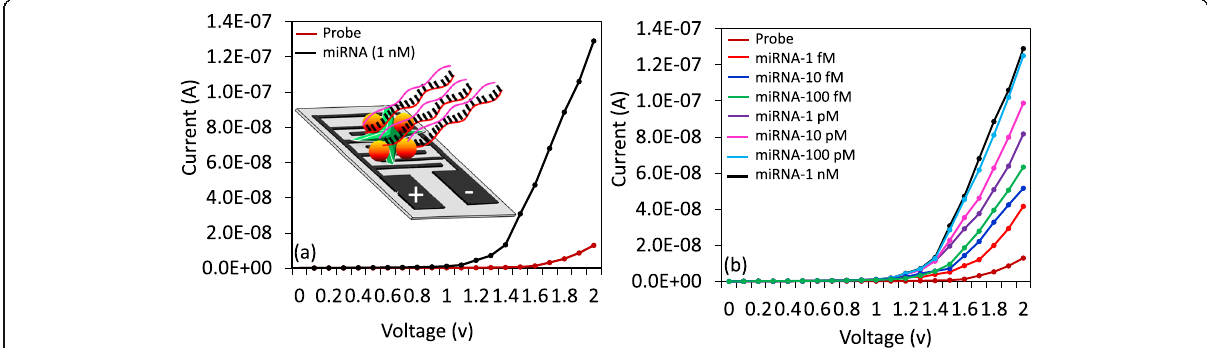
Fig. 4 Interactive analysis of the probe and target. a Higher-dose interaction of the probe and miRNA-335-5p (target). (dark red circle, probe; black circle, target). b Dose-dependent analysis of miRNA-335-5p. Testing from the lower femtomolar to the lower nanomolar range. (dark red circle, probe; orange circle, 1 fM; blue circle, 10 fM; green circle, 100 fM; purple circle, 1 pM; pink circle, 10 pM; light blue circle, 100 pM; black circle, 1